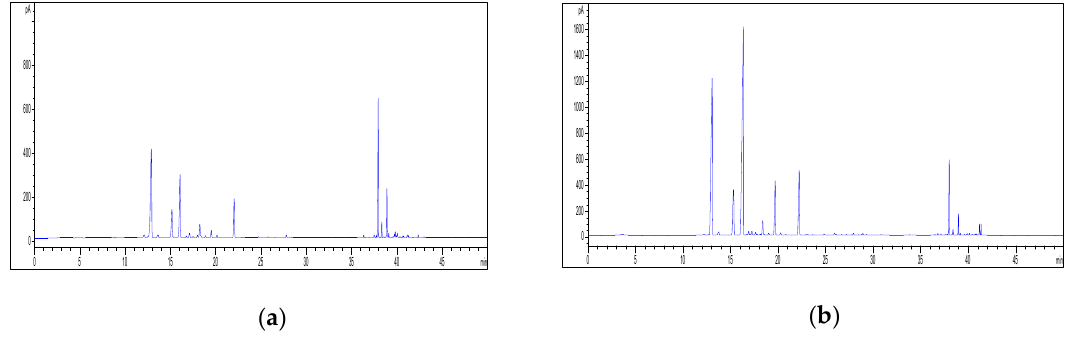
Figure 8. Effect of fibre type on the HS-SPME-GC-FID profiles of hemp inflorescences (sample C3): ( a ) PDMS fibre; ( b ) DVB/CAR/PDMS fibre.